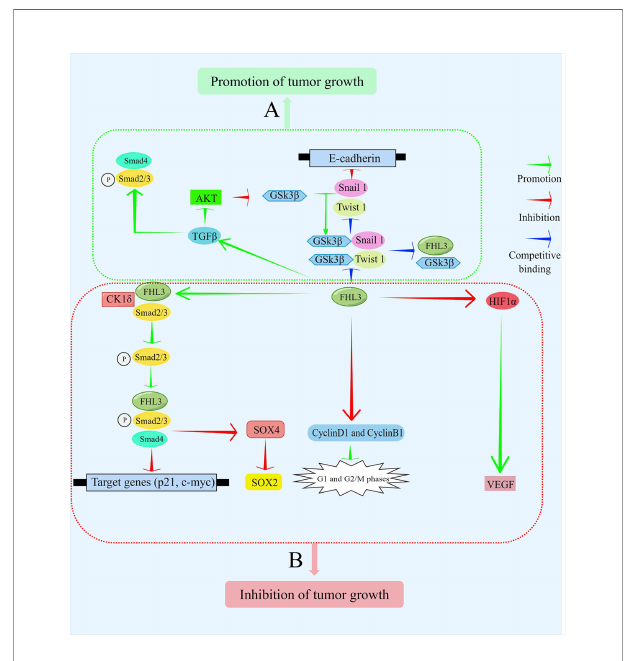
FIGURE 3 | FHL3 functions as an oncoprotein or tumor suppressor depending on the cellular context. It mediates the transduction of signaling pathways by interacting with other proteins, thereby controlling the expression of target genes. (A) In some contexts, FHL3 functions as a tumor promoter. FHL3 competitively binds GSK3 b to interfere with Snail1 and Twist1 to inhibit the expression of its target gene, E-cadherin. Additionally, FHL3 activates Smad2, Smad3, and Smad4 via TGF b to promote tumor growth. (B) In other contexts, FHL3 functions as a tumor suppressor. FHL3 promotes the phosphorylation and binding of Smad2 and Smad3 with CK1 d . Subsequently, the expression of the target genes, p21 and c-myc, can be decreased to inhibit tumor growth. SOX4 and SOX2 are also target genes that are downregulated to inhibit tumor growth. Additionally, FHL3 can inhibit cyclinsD1 and B1, affecting the G1 and G2 checkpoints. Moreover, FHL3 inhibits the expression and activity of VEGF by inhibiting HIF1 a